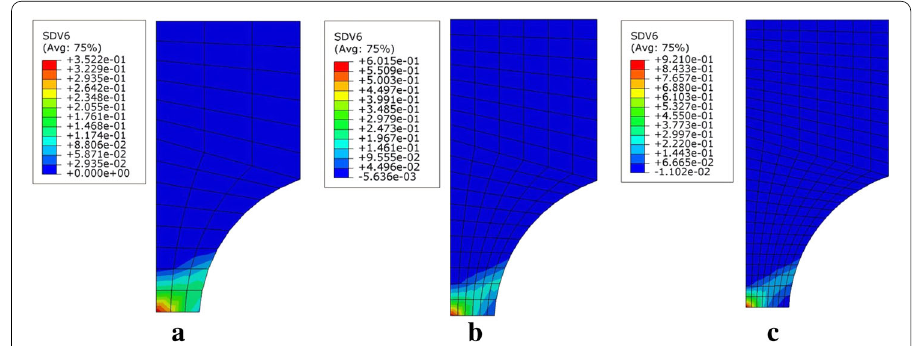
Fig. 4 Contour plots of the local damage propagation for mesh size of a h = 0 . 25mm, b h = 0 . 125mm and